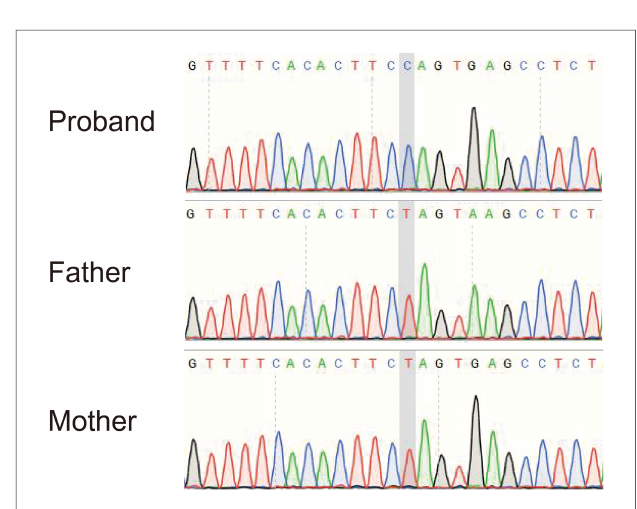
FIGURE 4 Sequencing result of the MT-ATP6 gene in the patient. The sequencing analysis revealed a de novo homogeneous variant (m.9176T>C) in the MT-ATP6 gene, which is one of the most common variants in Leigh